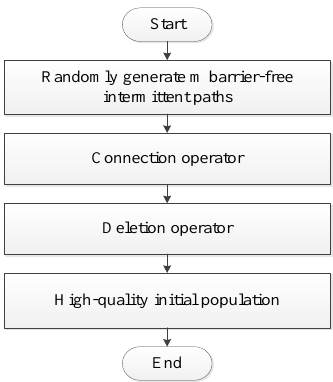
Figure 6. Flow chart of the initial population generation.